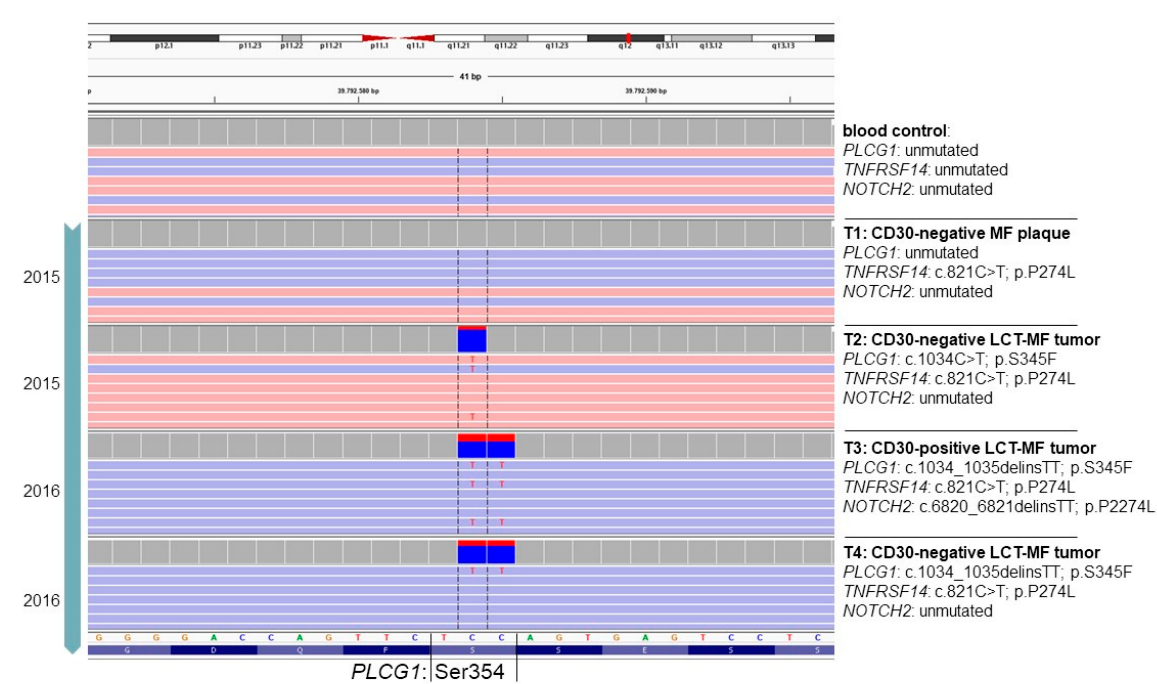
Figure 2. Intra-individual and intra-genic genetic heterogeneity of patient #1 during clinical course. Illustration of the genetic profile of the PLCG1 hotspot Serine 354 in IGV (Integrative Genomic Viewer) of four different MF samples over time and the patient´s unmutated control tissue (blood). Moreover, additionally occurring mutations in TNFRSF14 and NOTCH2 are indicated on the right side along with LCT and CD30 status.